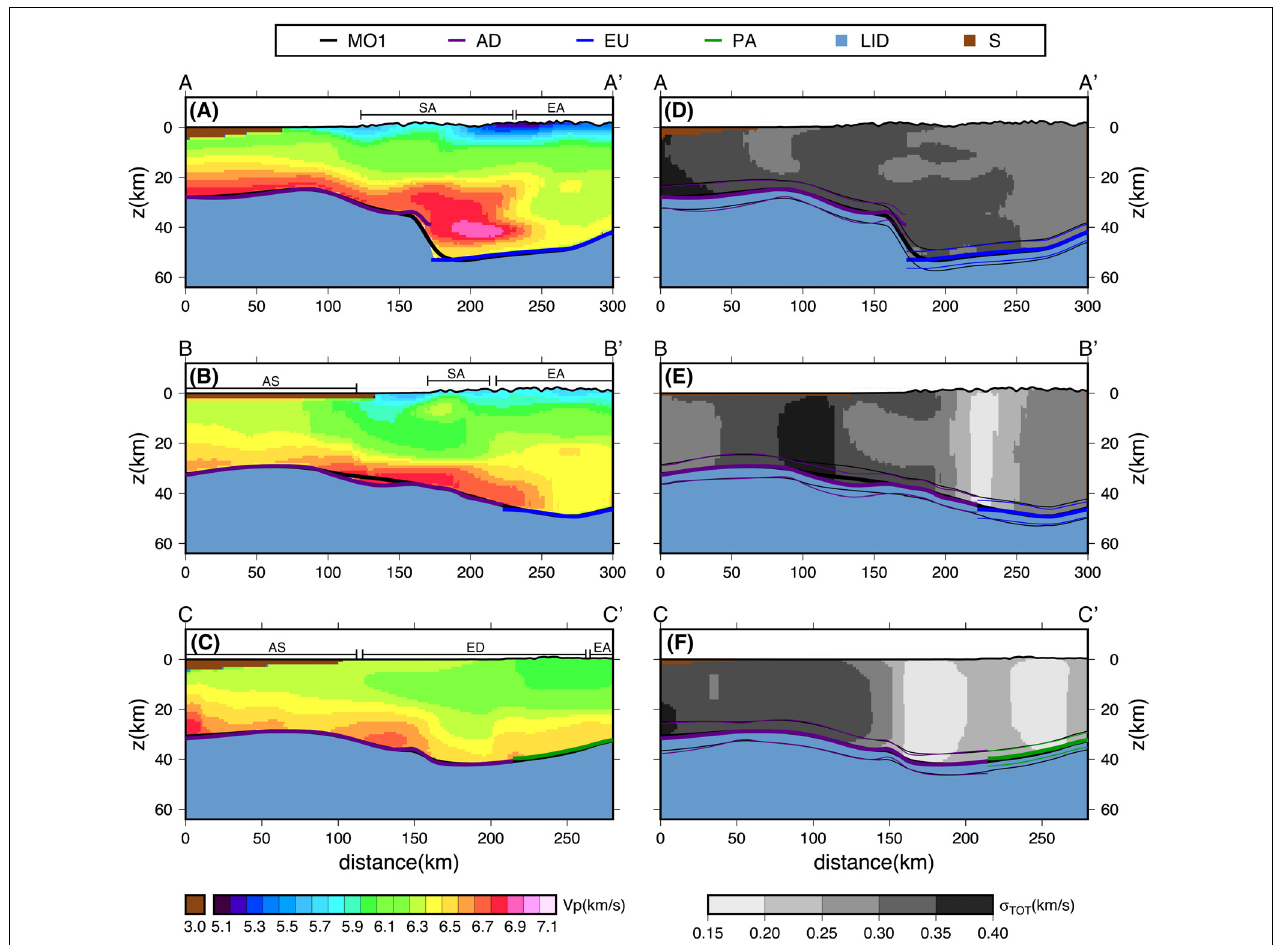
FIGURE 10 | V P values along vertical sections for the profiles AA’, BB’, and CC’ of Figure 9E . Black line: trace of MO1; violet line: trace of Adria (AD) Moho; blue line: trace of Eurasia (EU) Moho; green line: trace of PA Moho. SA, Southern Alps; EA, Eastern Alps; AS, Adriatic Sea; ED, External